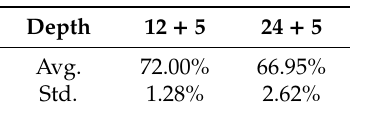
Table 5. Test accuracy with di ff erent depth settings of the 1d